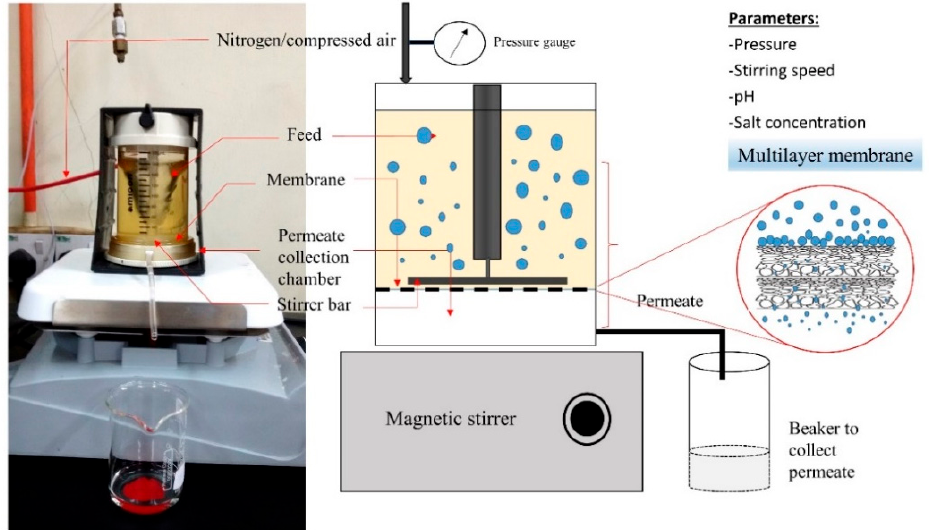
Figure 1. Schematic diagram of membrane system for fractionation of tilapia by-products (TB) hydrolysate using multilayer membranes.